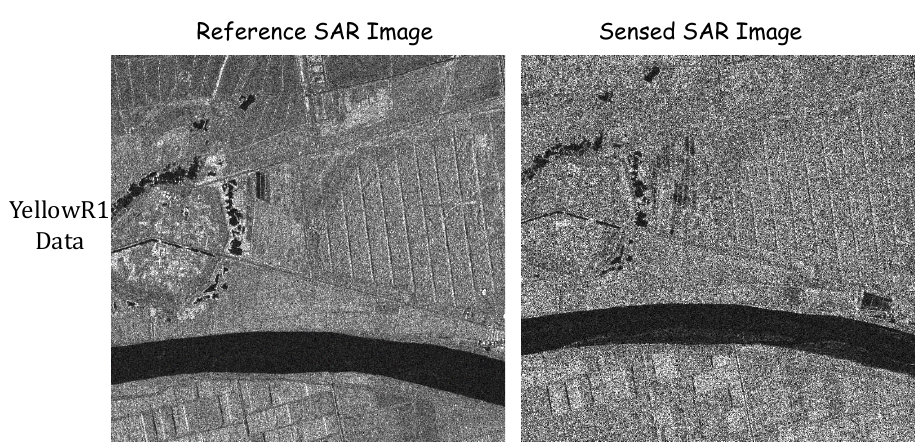
Figure 6. Reference and Sensed Images of YellowR1 Data.